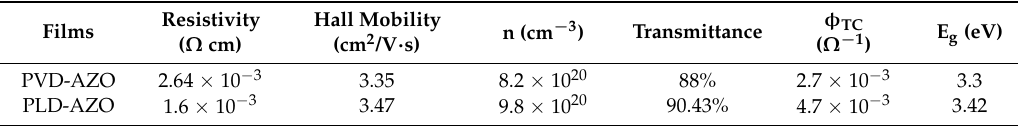
Table 1. Performance parameters’ comparison of AZO films deposited by PVD and PLD.